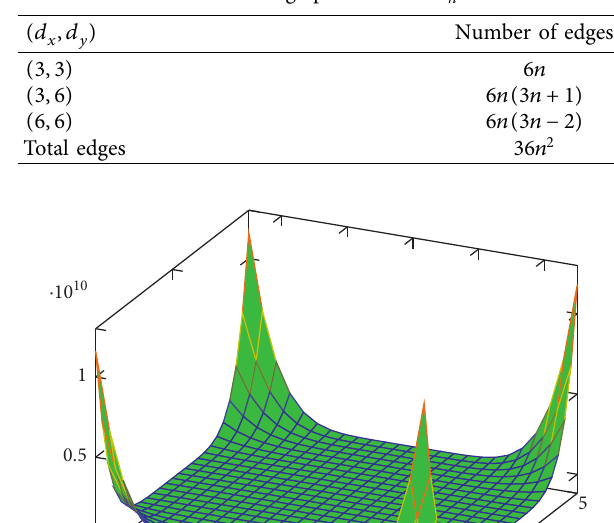
Table 3: Edge partition of SL